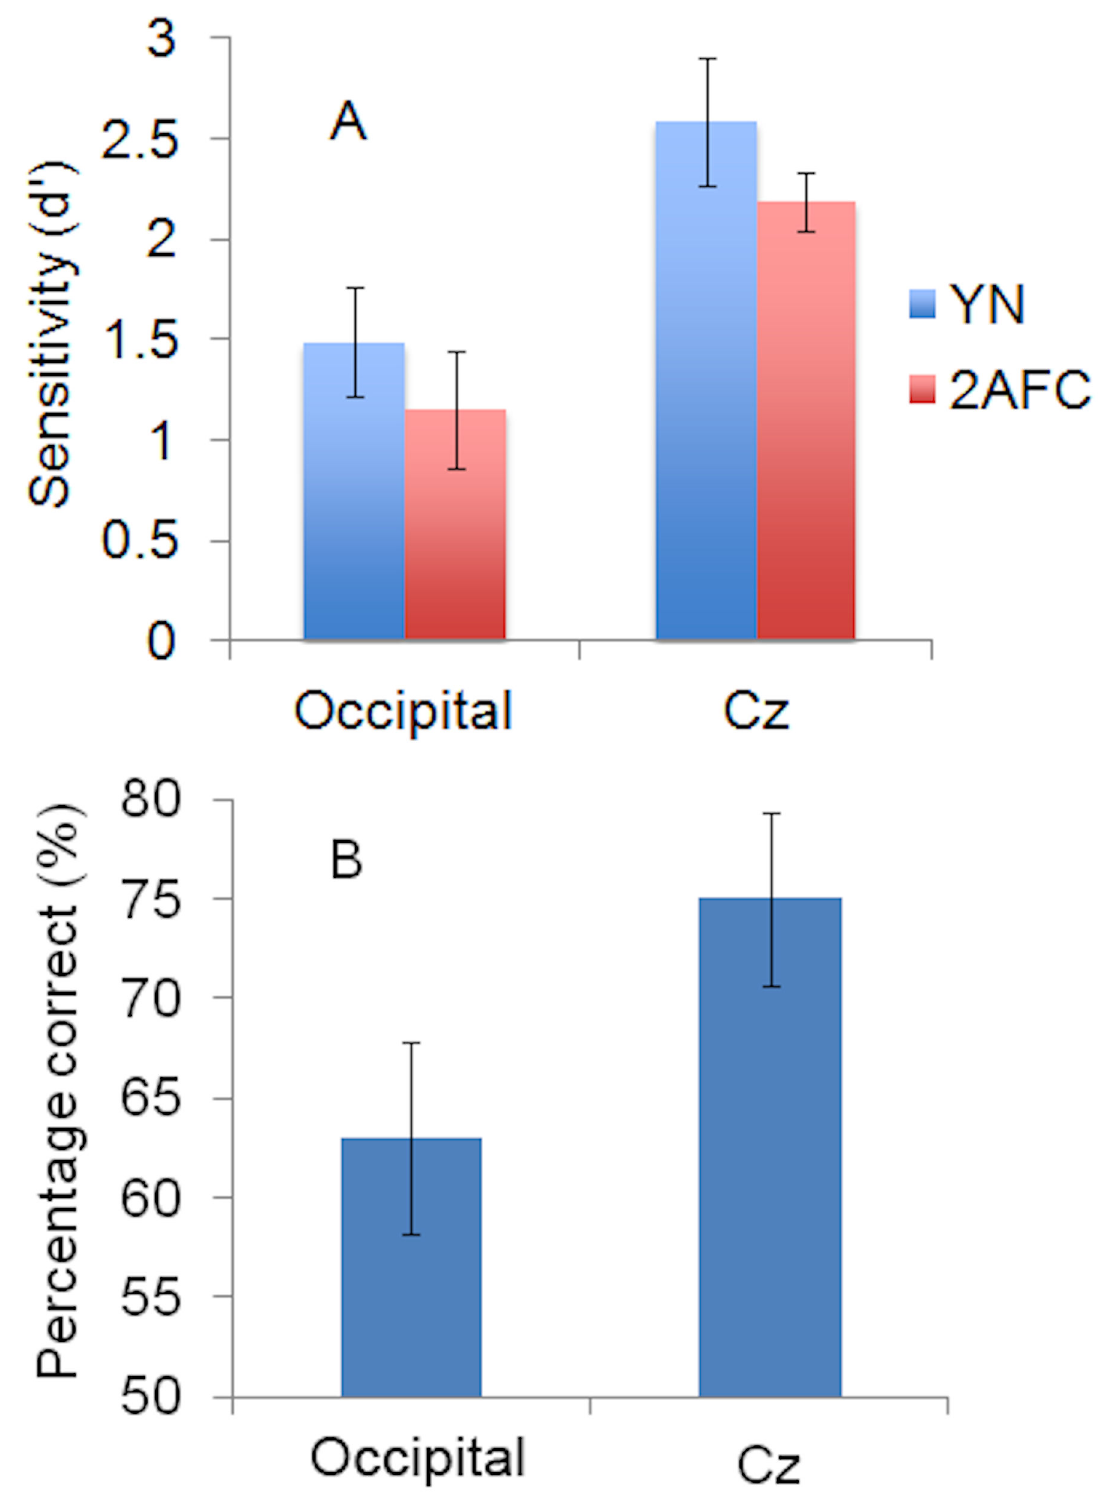
Figure 5. Evidence for TMS-induced Unconscious Vision. A . Visual sensitivity under Yes-No (YN) and Forced-Choice (FC) response conditions during TMS stimulation of Occipital Cortex and Cz. B . Percentage of correct orientation judgments on miss trials during TMS to Occipital Cortex and Cz. Vertical bars show the standard error of the mean.